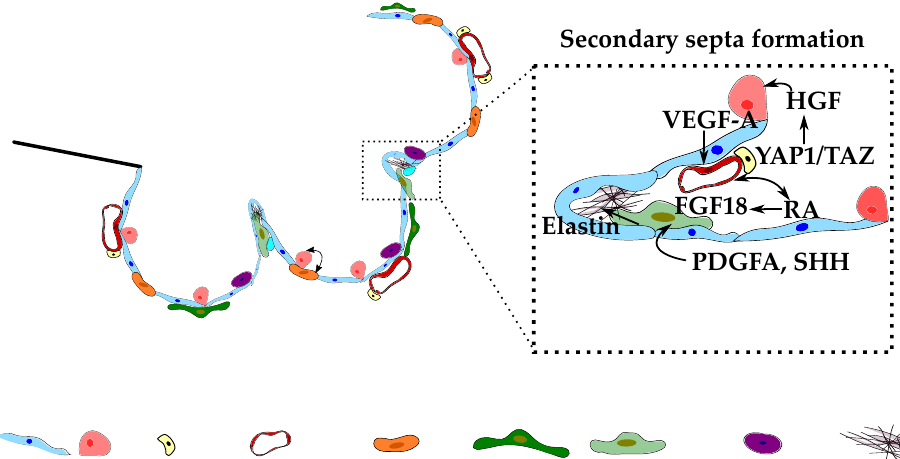
Figure 5. Schematic representation of the signaling events occurring during alveologenesis, partic- ularly secondary septa formation. Left image: alveolar niche. Right image: magnification of the secondary